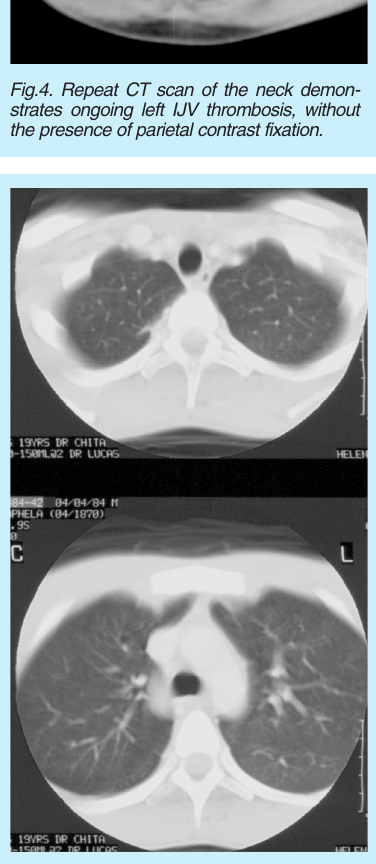
Fig.5. Repeat CTscan of the lung apices con- firms resolution of pulmonary nodules and pleural